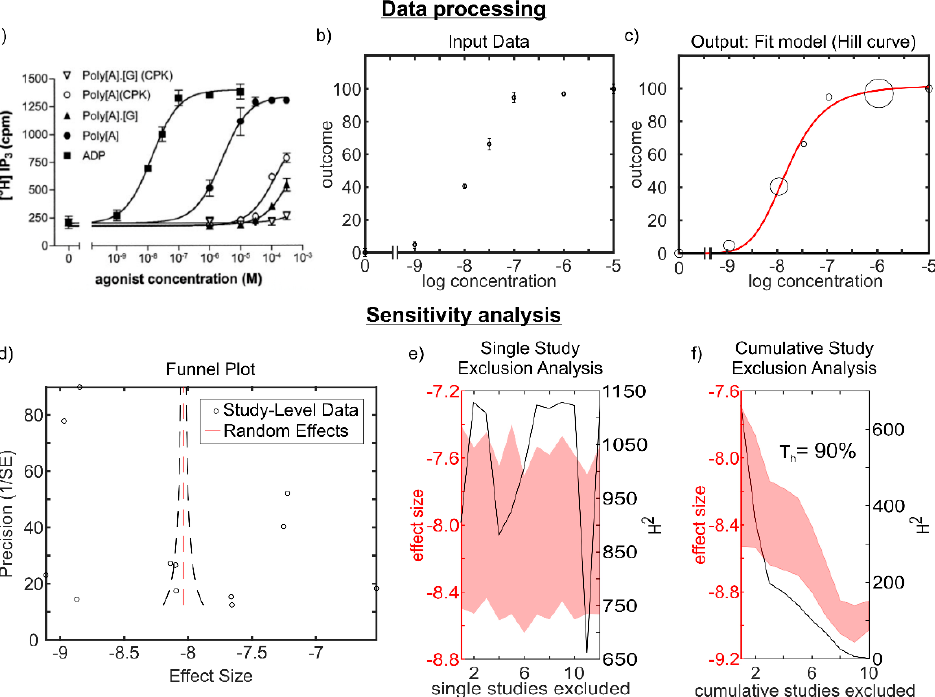
Figure 2. Data processing and sensitivity analysis in Ca 2+ /IP 3 datasets. ( a ) Example of a concentration-dependence curve from a study (Marteau et al. 2003 # , reproduced with permission) that was used to extract P2Y13-mediated responses. ( b ) Extracted dataset was used as an input to fit into the Hill function. ( c ) Final output of the dataset fit into the Hill curve after Monte-Carlo simulations. ( d ) Heterogeneity was analyzed in Ca 2+ /IP 3 release dataset using a forest plot. Study-level (log10) effect sizes (black circles) were plotted against the precision (inverse standard error). The red dashed line represents the random effects estimate. ( e ) Single study and ( f ) cumulative study exclusion analysis was carried out to assess studies that contributed to heterogeneity. Red shaded region: 95% confidence interval; black line: H 2 statistic; T h : homogeneity threshold # Reference. Marteau, F.; Le Poul, E.; Communi, D.; Communi, D.; Labouret, C.; Savi, P.; Boeynaems, J.M.; Gonzalez, N.S. Pharmacological characterization of the human P2Y13 receptor. Mol. Pharmacol. 2003 , 64 , 104–112, doi:10.1124/mol.64.1.104